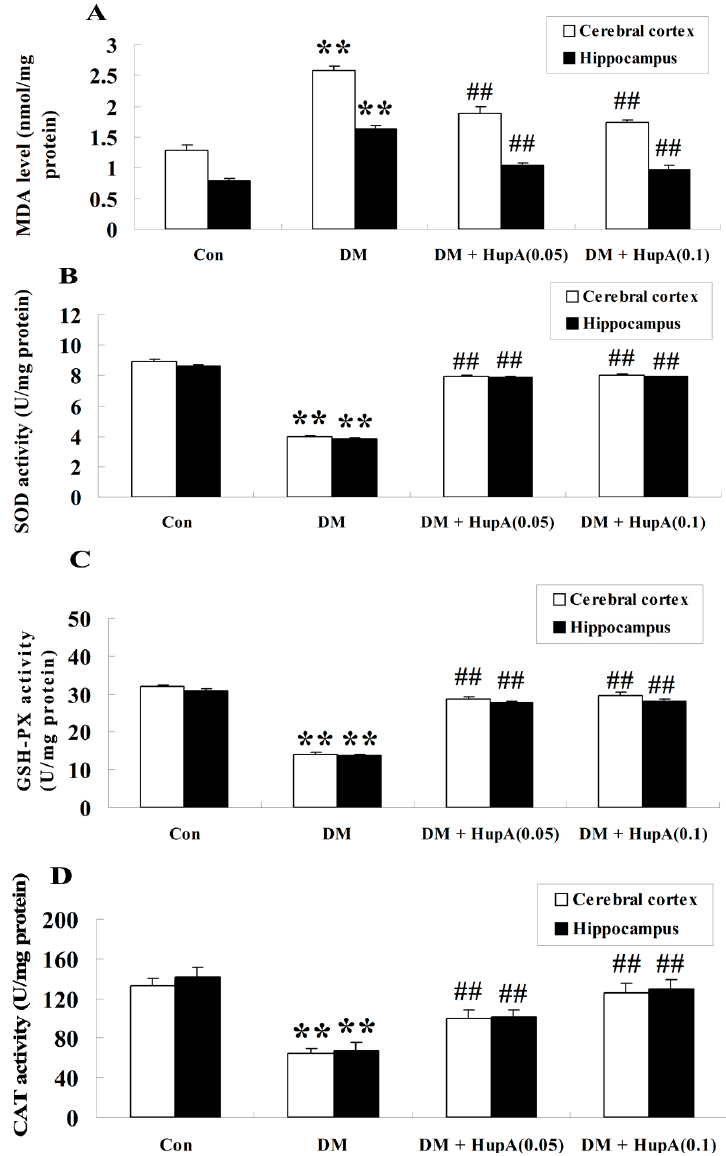
Figure 6. Effects of HupA on the oxidative stress in cerebral cortex and hippocampus of control and diabetic rats ( n = 8, mean ± S.D.). ( A – D ) showed the oxidative production of MDA, SOD, GSH-PX and CAT activities, respectively in the cerebral cortex and hippocampus of control and diabetic rat brain. ** p < 0.01 compared with Con group; ## p < 0.01 compared with DM group. Con, control; DM, diabetes; DM + HupA (0.05), huperzine A (0.05 mg/kg)-treated; DM + HupA (0.1), huperzine A (0.1 mg/kg)-treated